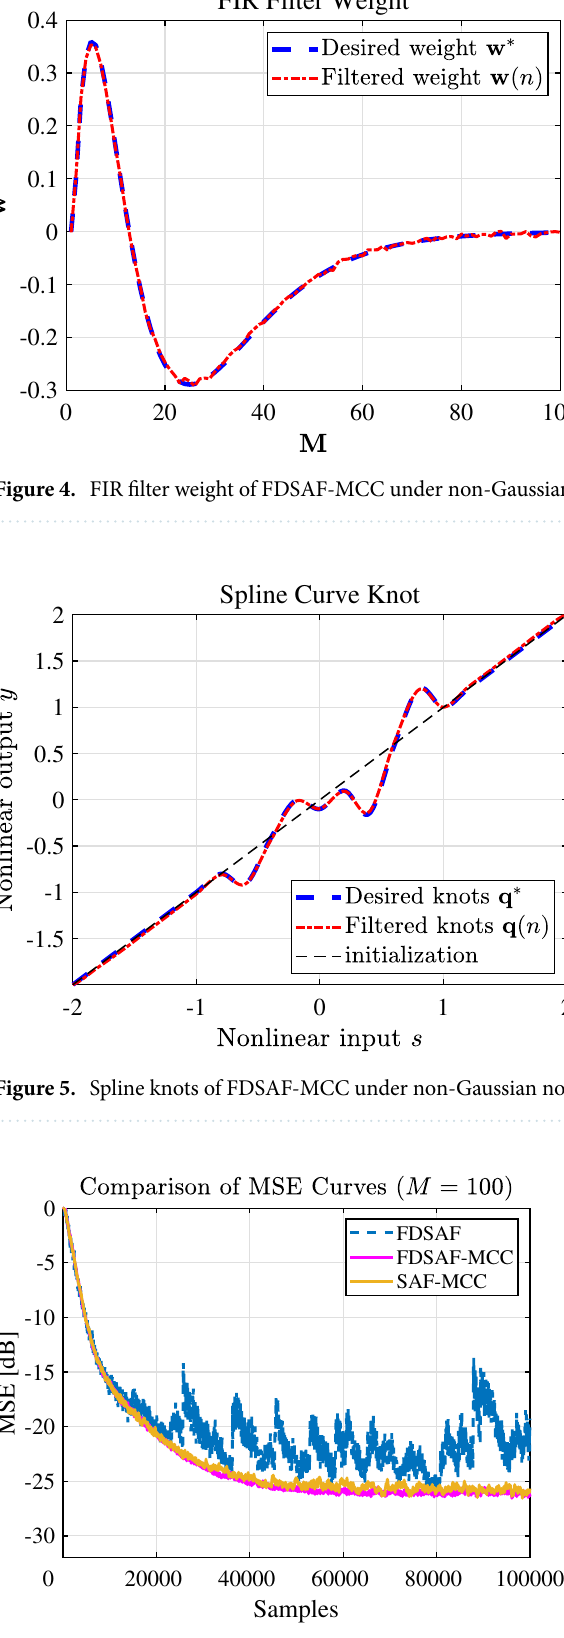
Figure 6. Experiment 1: Comparison of MSE curves of FDSAF, FDSAF-MCC, and SAF-MCC algorithms with impulsive